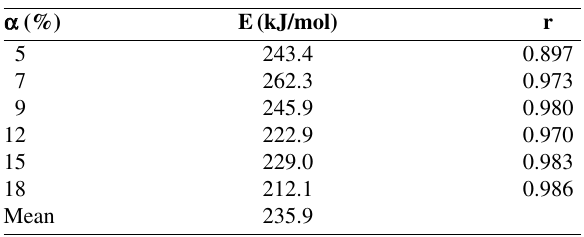
Table 1. Activation energies obtained using the Flyn-Wall-Ozawa method.